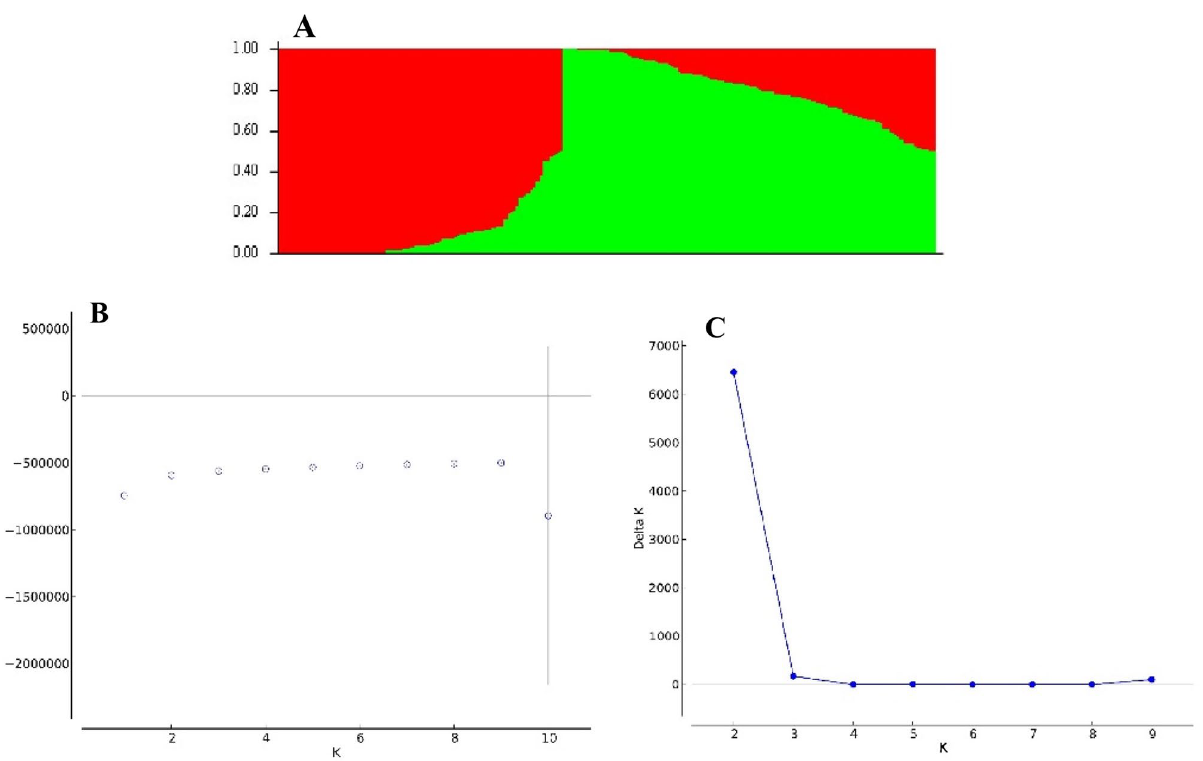
Figure 4. Barplot ( A ), the average log-likelihood value ( B ), and delta K for different numbers of sub- populations ( C ), in the analysis of population structure using 43,446 SNP